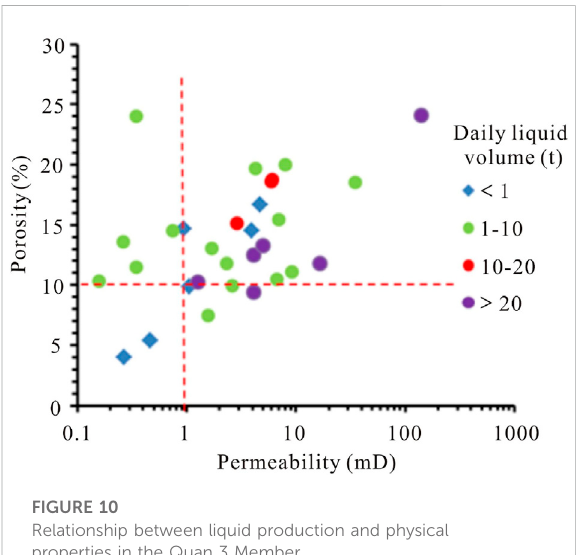
FIGURE 10 Relationship between liquid production and physical properties in the Quan 3